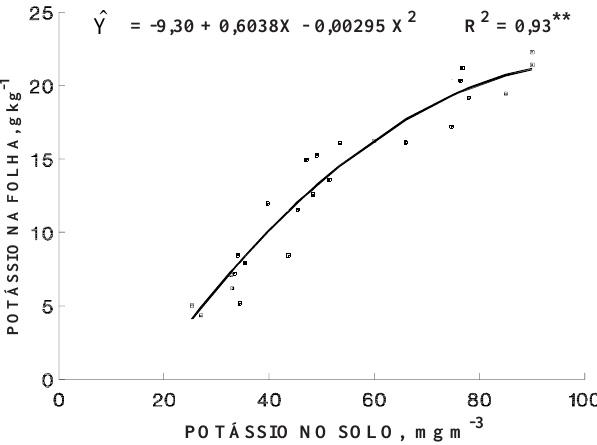
Figura 2. Teor médio de potássio no tecido foliar de soja em função do teor do nutriente no solo. Resultado de quatro safras. Média de três repetições.